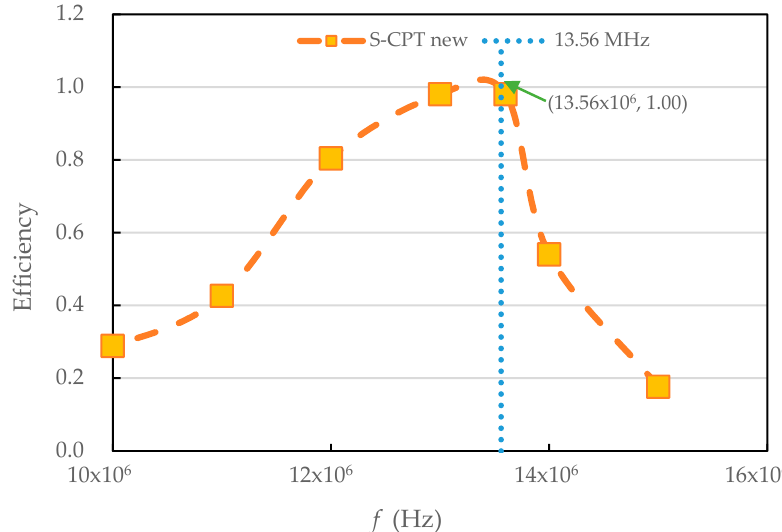
Figure 19. Efficiency of S-CPT system at various frequencies.